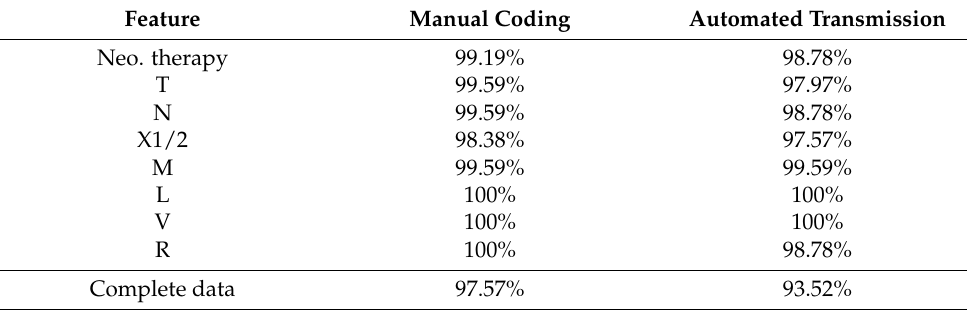
Table 1. Accuracy of Feature Extraction.